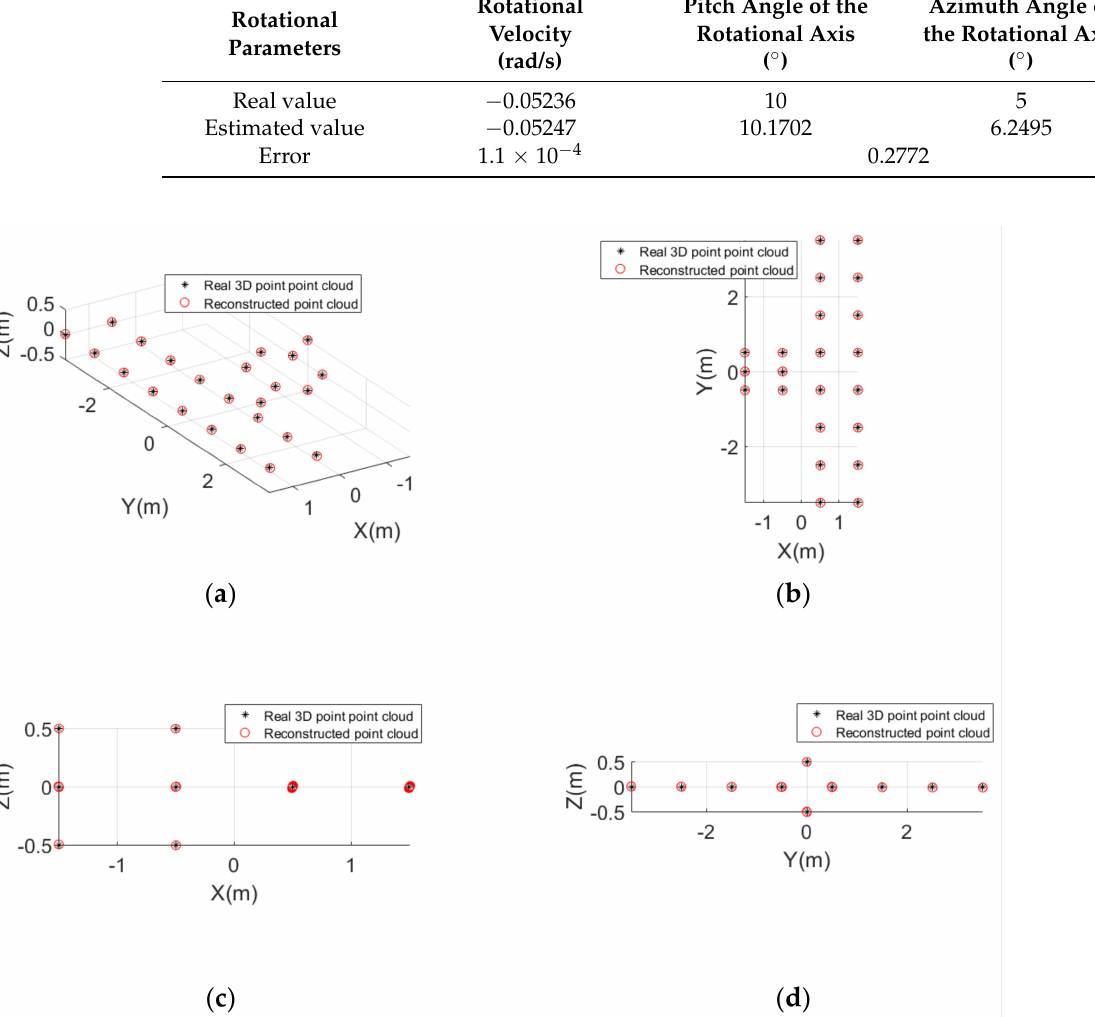
Figure 6. The reconstructed 3D point cloud of the simulated point model: ( a ) The reconstructed 3D point cloud, ( b ), ( c ), and ( d ) top, side, and front